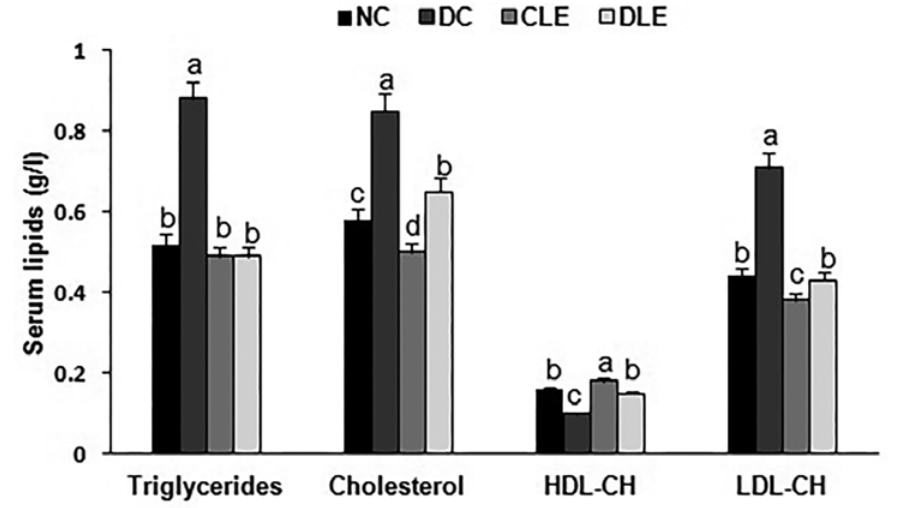
FIGURE 1 - Comparative levels of serum triglycerides, cholesterol, HDL-CH and LDL-CH in different rat groups. Groups are labelled as follows: Group NC: normal control, Group DC: diabetic control, Group CLE: Normal control fed with Lycium europaeum extract, Group DLE: Diabetic rats treated fed with Lycium europaeum extract. Data are expressed as mean ± SD of measurements from 6 rats. Means not sharing common letters are significantly different among the groups at P ≤ 0 . 05 as determined by Duncan’s multiple range